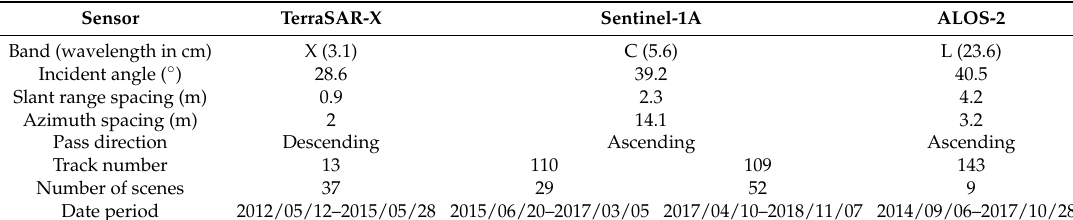
Table 1. Basic parameters of the three SAR